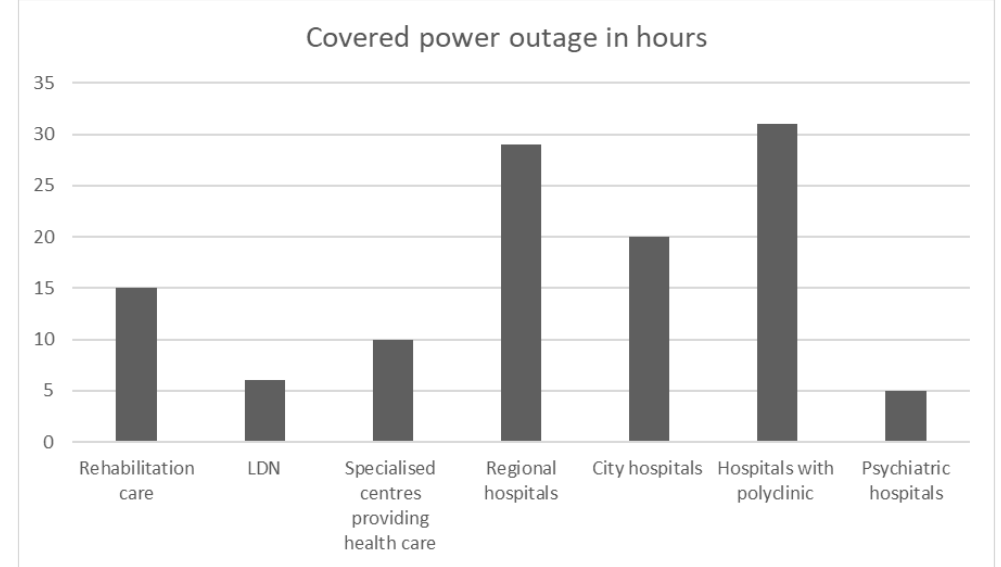
Figure 4. Covered power outage in hours.